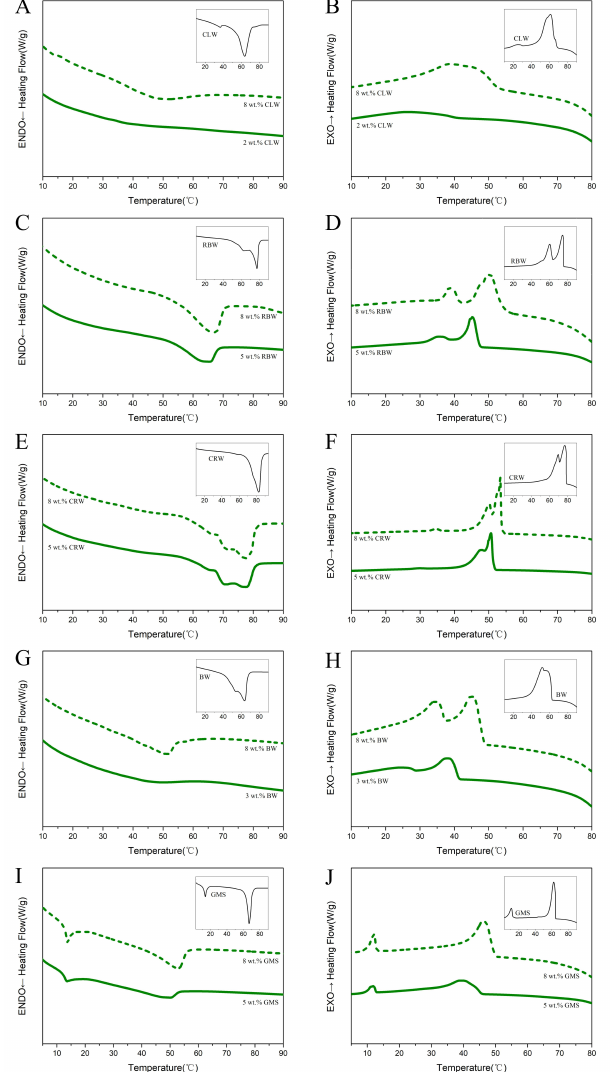
Figure 4. DSC thermograms during heating ( A ) and cooling ( B ) of CLW oleogels. DSC thermograms during heating ( C ) and cooling ( D ) of RBW oleogels. DSC thermograms during heating ( E ) and cooling ( F ) of CRW oleogels. DSC thermograms during heating ( G ) and cooling ( H ) of BW oleogels. DSC thermograms during heating ( I ) and cooling ( J ) of GMS